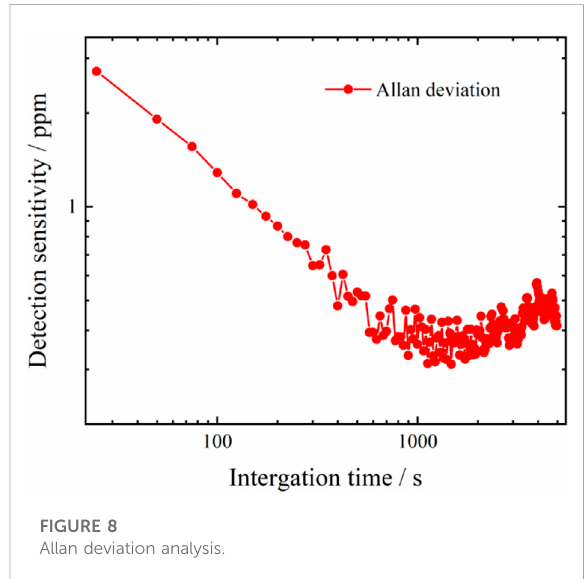
FIGURE 8 Allan deviation